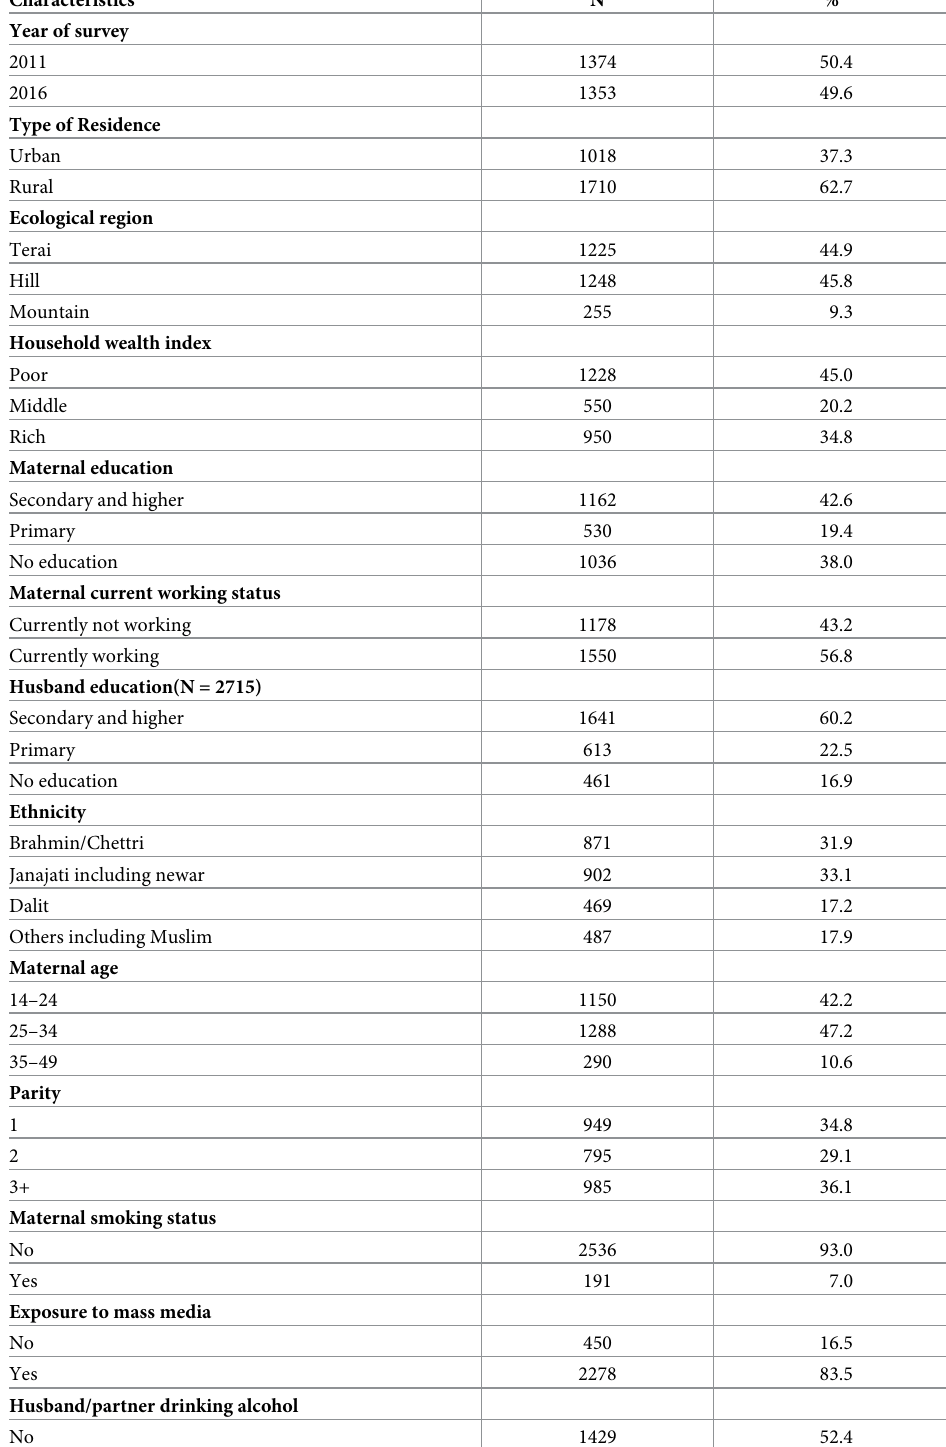
Table 1. Characteristics of study sample (weighted) with live births who were interviewed for domestic violence module in Nepal (2011–2016).